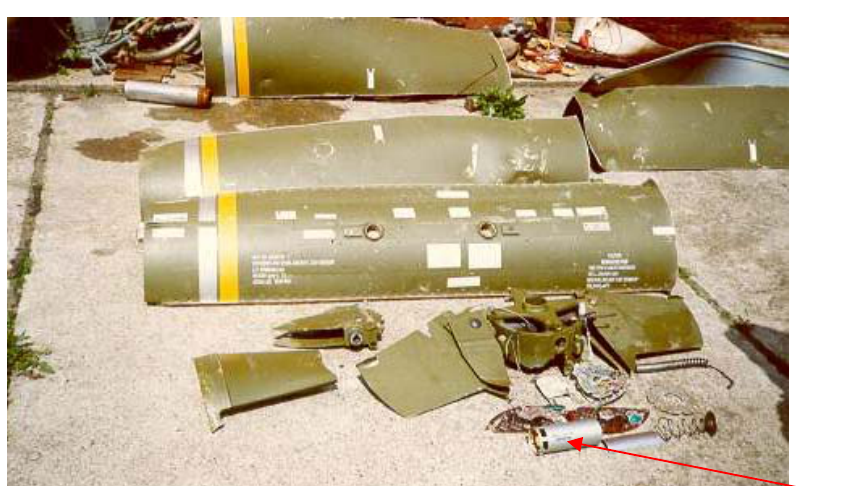
Figure 1 – Parts of an activated CBU-102/B cluster bomb (in Figures 1 and 2, inactivated BLU-114/B bomblets are marked with the arrows) (Serbian Armed Forces, 1999) Рис . 1 – Части активированной кассетной бомбы CBU-102/B ( на рисунках 1 и 2